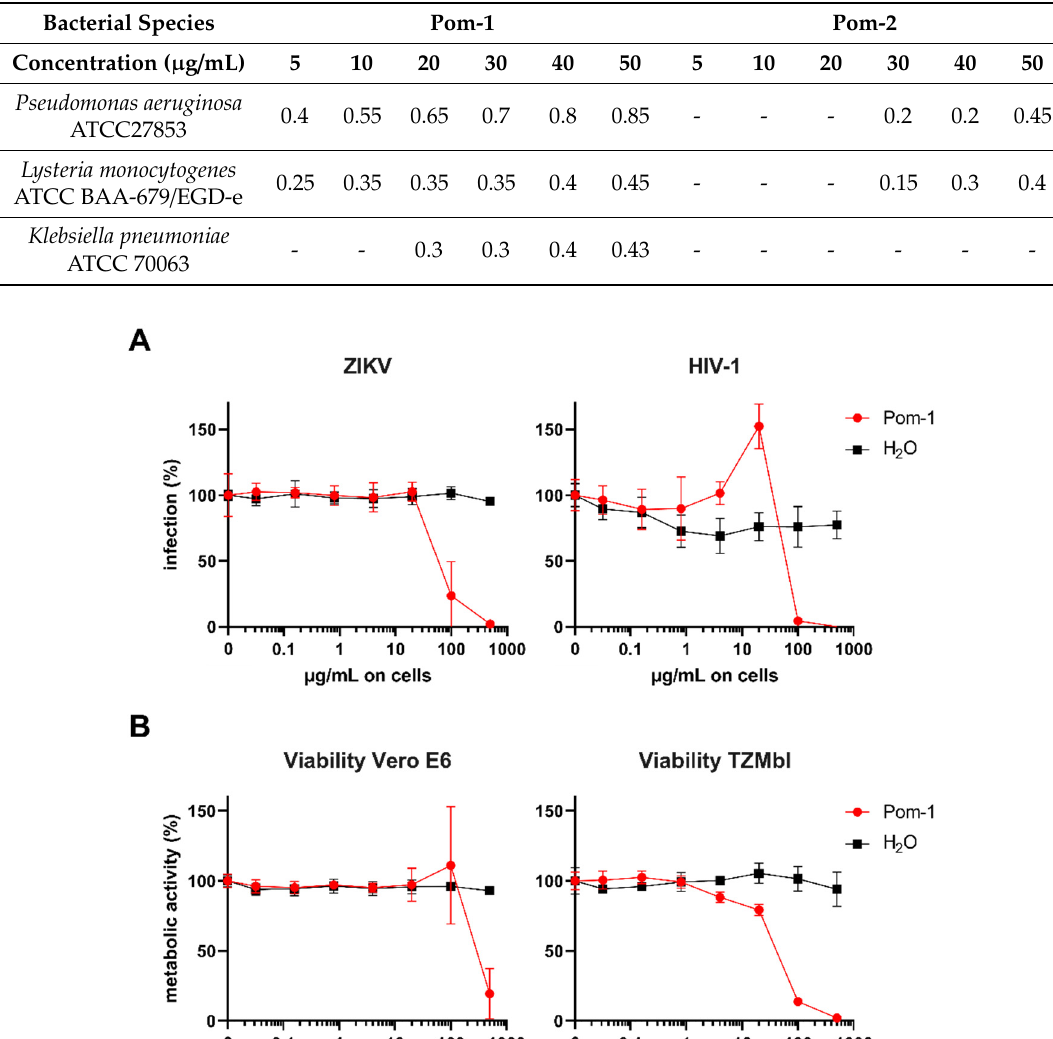
Table 3. Agar diffusion test of Gram-positive and Gram-negative bacterial species against Pomacea poeyana peptides.